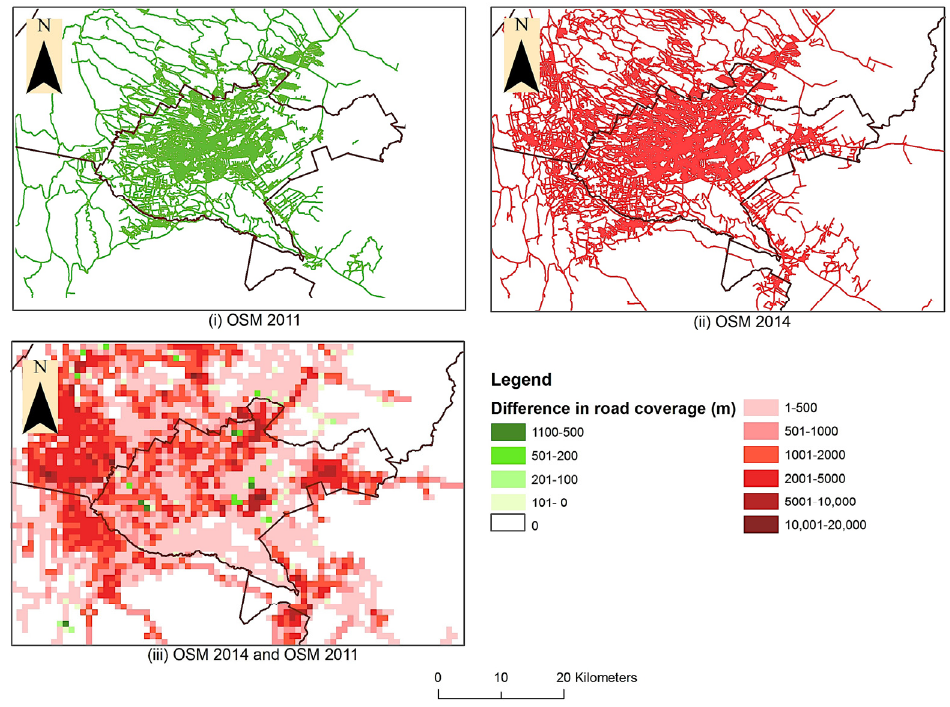
Figure 6. OSM Road Networks in ( i ) 2011; and ( ii ) 2014; and ( iii ) difference in Road Coverage between OSM 2011 and 2014 (where green represents areas where road coverage was reduced and red represents areas where road coverage was increased between 2011 and 2014).